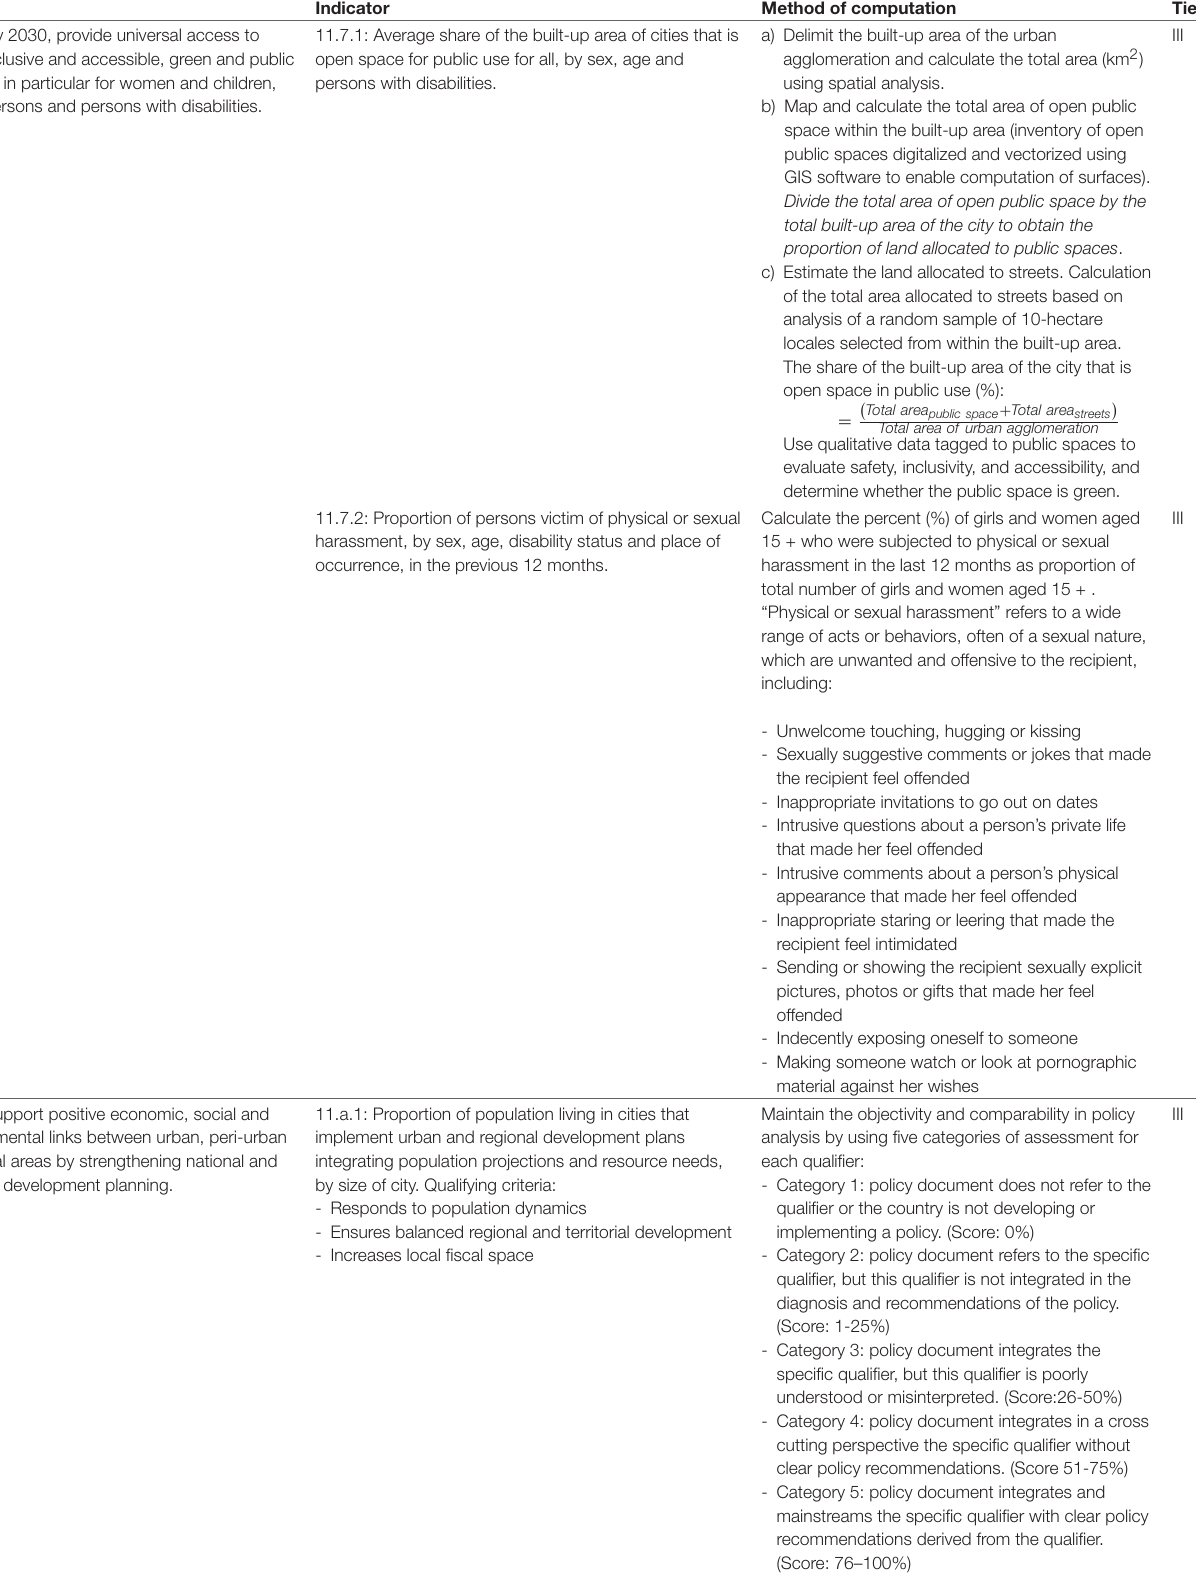
Target Indicator Method of computation